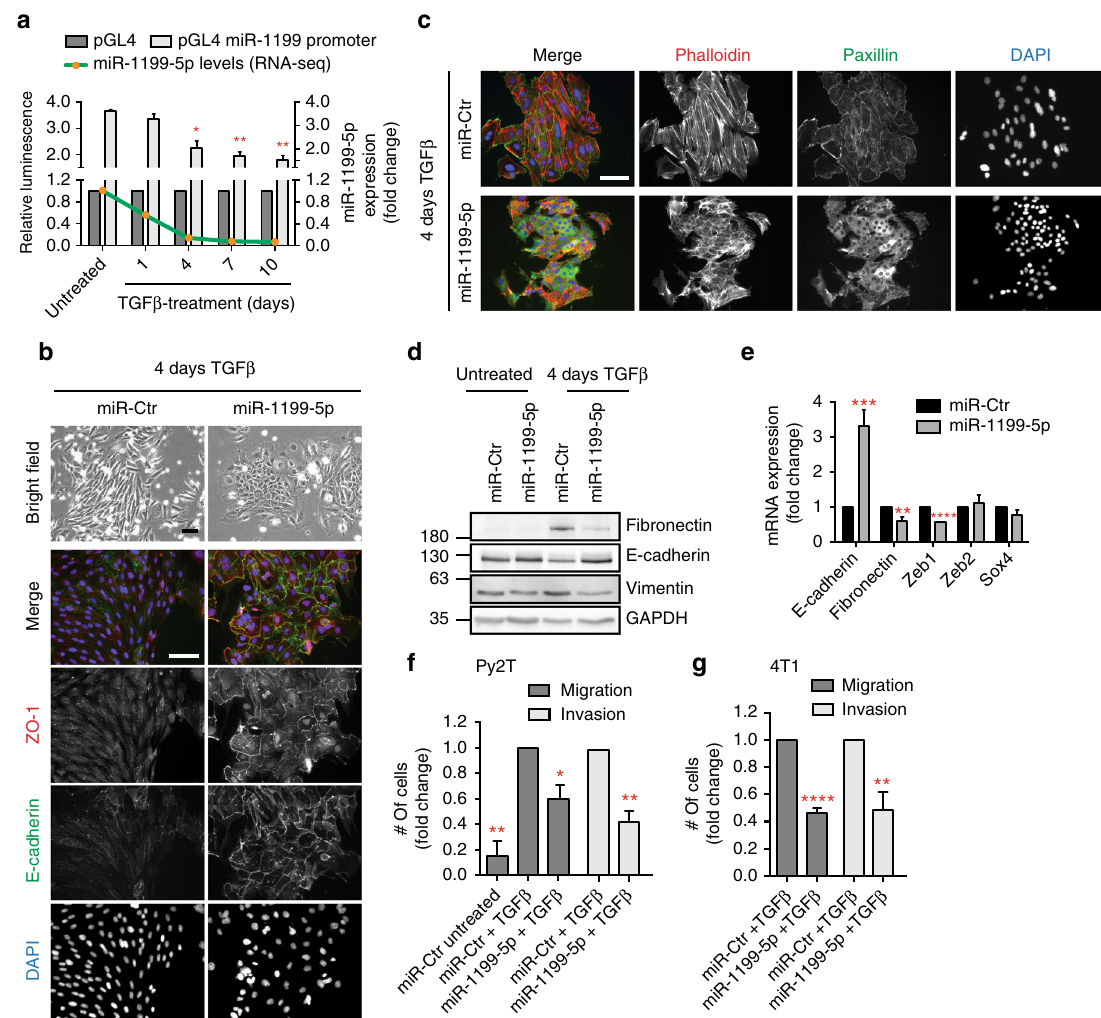
Fig. 2 miRNA-1199-5p inhibits an EMT and tumour cell migration and invasion. a miR-1199-5p transcript and miR-1199 promoter activity levels decrease during a TGF β -induced EMT. Green line: expression pro fi le of miR-1199-5p during EMT in NMuMG/E9 cells as determined by RNA sequencing. Grey bars: miR-1199 promoter activity during an EMT. NMuMG/E9 cells were treated with TGF β for the time points indicated and transfected with a Renilla luciferase reporter along with either a miR-1199 promoter Fire fl y luciferase reporter (pGL4 miR-1199 promoter) or a control reporter (pGL4; Supplementary Fig. 3b). Relative luminescence (Fire fl y/Renilla) was calculated and normalized to the control reporter (mean fold changes ± s.e.m.; n = 3; signi fi cance determined by an unpaired, two-sided t test; * P < 0.05, ** P < 0.01). b , c NMuMG/E9 cells were transiently transfected with the miRNA mimics indicated and cultured in presence of TGF β for 4 days (4-day TGF β ). Bright- fi eld images of NMuMG/E9 cells illustrate the differences in cell morphology. Immuno fl uorescence images of NMuMG/E9 cells visualize different epithelial and mesenchymal cell structures as indicated. Scale bars: 100 μ m. d , e Immunoblot ( d ) and quantitative RT-PCR mRNA ( e ) expression analysis of NMuMG/E9 cells transiently transfected with miRNA mimics for the EMT markers indicated (mean fold changes ± s.e.m.; n = 6; signi fi cance determined by an unpaired, two-sided t test, Student ’ s t test; ** P < 0.01, *** P < 0.001, **** P < 0.0001). f , g Mesenchymal ( > 20 days TGF β ) Py2T ( f ) and 4T1 ( g ) cells were transiently transfected with the miRNA mimics indicated and re-plated within a FCS gradient of a Boyden chamber migration or invasion insert. Nuclei of transmigrated and invaded cells were quanti fi ed after 18 h (mean fold changes ± s.e. m.; migration: n = 3; invasion Py2T: n = 3, 4T1: n = 4; signi fi cance determined by an unpaired, two-sided t test; * P < 0.05, ** P < 0.01, **** P < As expected, forced expression of miR-1199-5p induced a block in a TGF β -induced EMT in these cells and led to an overall anti- correlative ( r = − 0.324) transcriptomic pro fi le compared to genes regulated in their expression during an EMT (miR-Ctr 4d vs. expressed (log2 fold change of ± 1 (log2FC( ± 1)); False Discovery Rate (FDR) < 0.05) by the ectopic expression of miR-1199-5p during an EMT. Subsequent functional annotation analysis by DAVID (Database for Annotation, Visualization and Integrated Discovery) 28, 29 for biological processes (GO (gene ontology)) and cellular pathways (Kyoto Encyclopedia of Genes and Genomes;